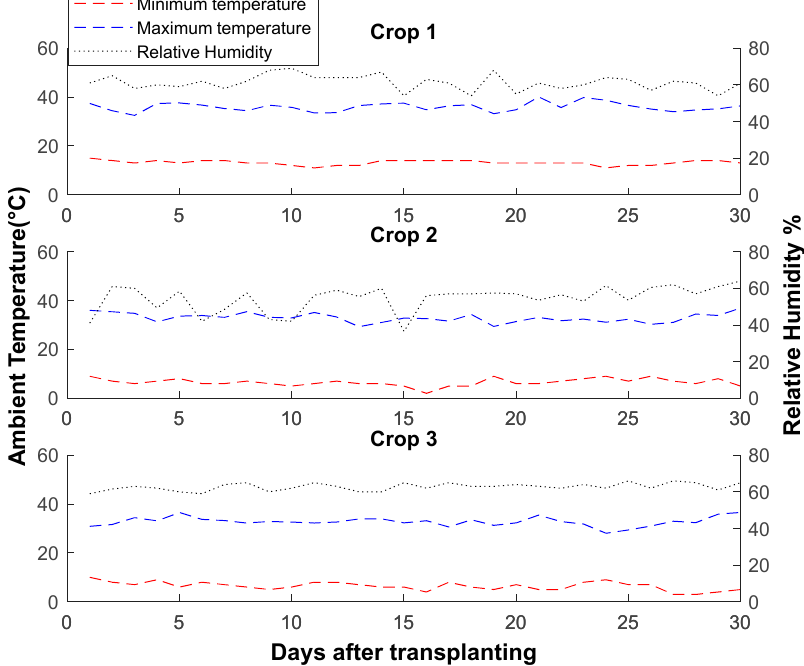
Figure 2. Measured temperature and relative humidity throughout the growing period.